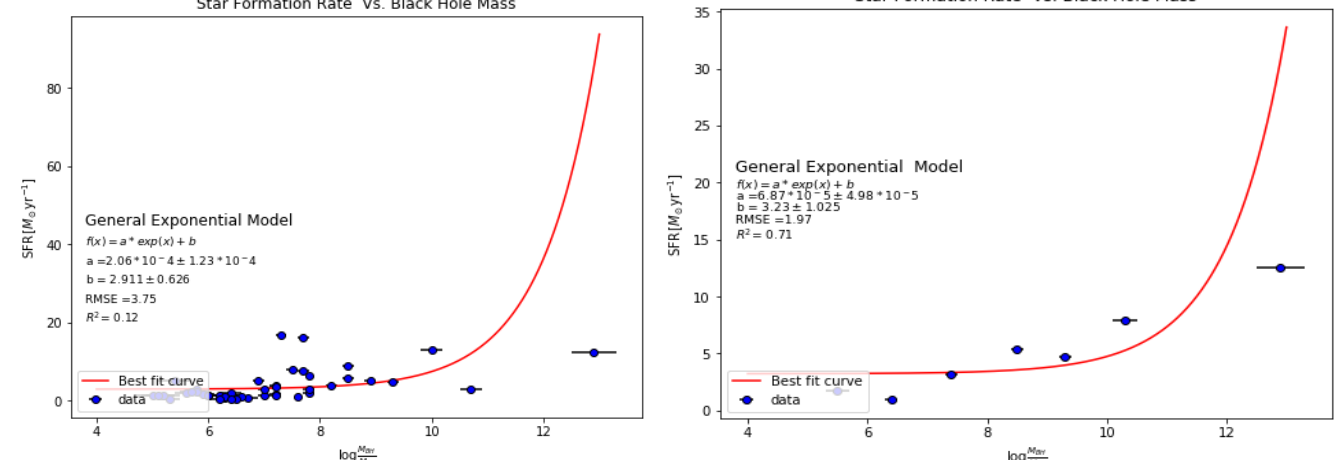
Fig. 5: The correlation between the SMBH & SFR for seyfert1 galaxies using exponential regression, where (a) for all samples, (b) median data.